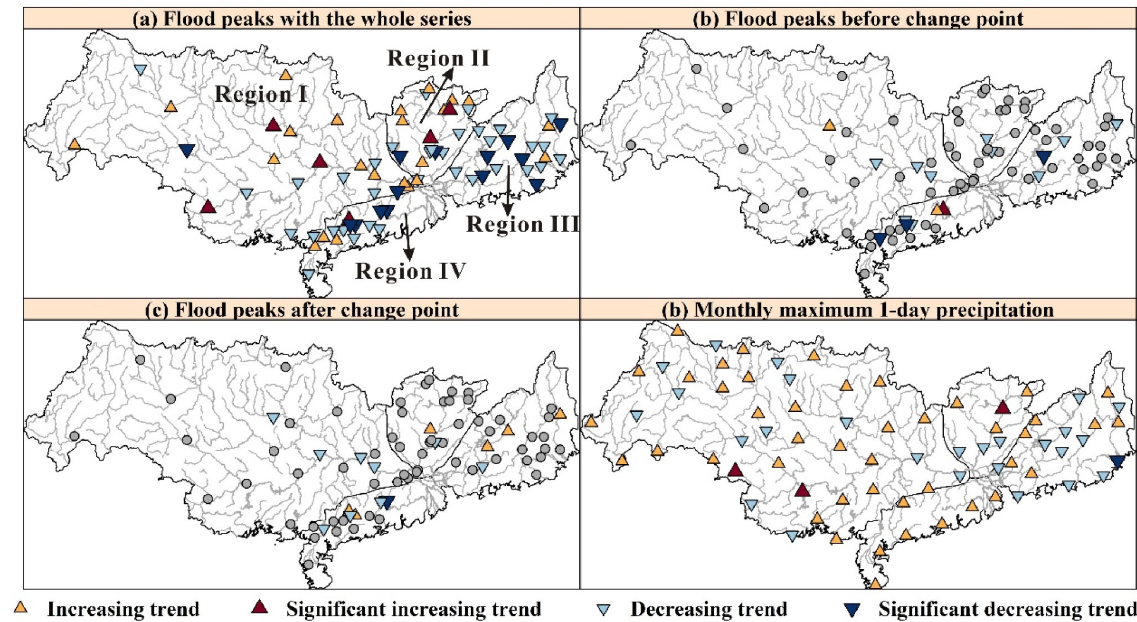
Figure 4. Trends in (a) flood peaks with the whole series, (b) flood peaks before the change point, (c) flood peaks after the change point, and (d) precipitation extremes. The gray dots in (b) and (c) indicate the stations without a change